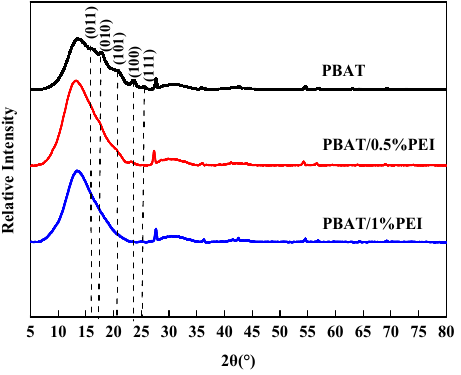
Figure 2. XRD for PBAT and PBAT/PEI films.